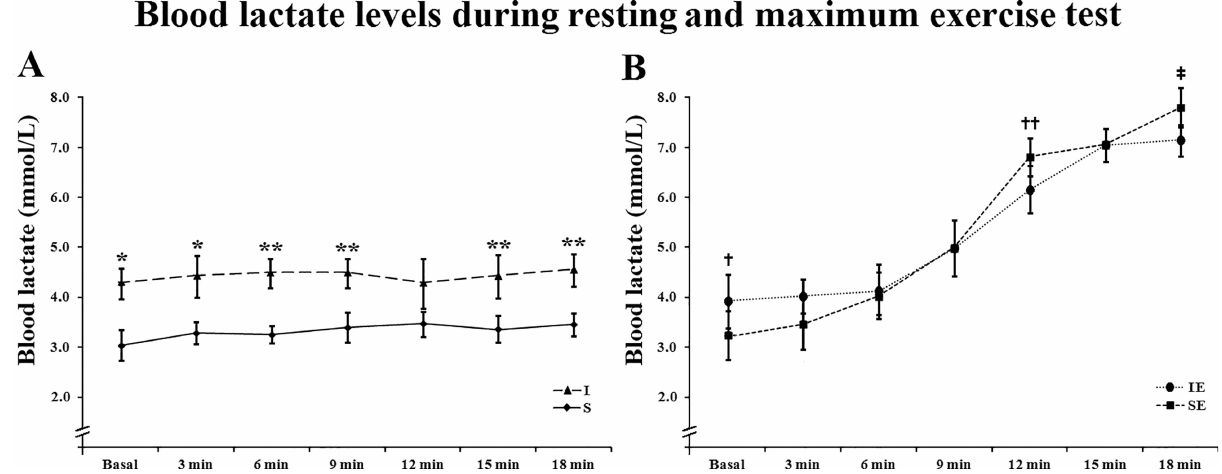
Figure 3 - Blood lactate curve during resting and an intense exercise session for the same period. S: sham-operated rats without intense exercise session; SE: sham-operated rats + intense exercise session; I: acute myocardial infarction induced by left coronary artery ligation; IE: acute myocardial infarction induced by left coronary artery ligation + intense exercise session. Two way ANOVA was performed (p < 0.001) followed by Bonferroni’s post-hoc test: Panel A (lactacidemia during resting), * p=0.001 vs. S group and ** p < 0.001 vs. S group; Panel B (lactacidemia during an intense exercise session), † p=0.040 vs. SE, †† p=0.042 vs. SE and ‡ p=0.038 vs. SE.